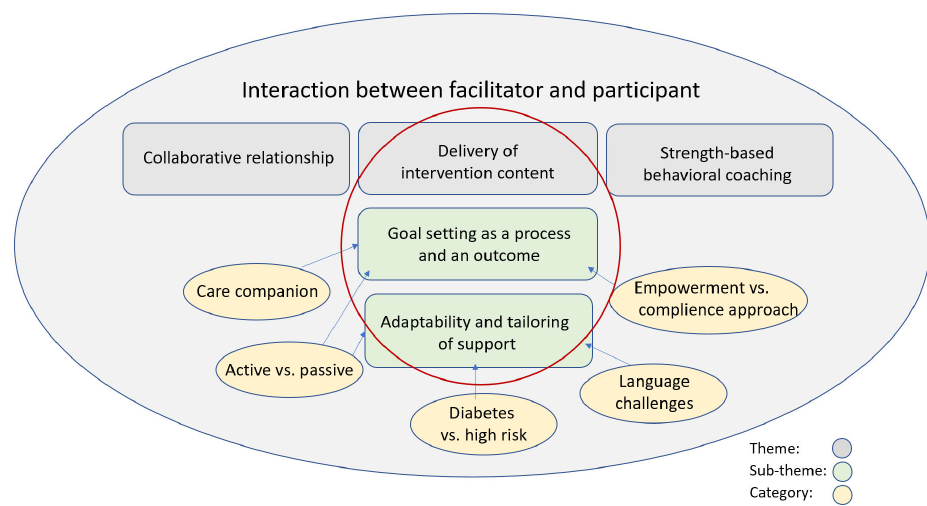
Figure 4. Thematic map showing themes and subthemes developed from the data.